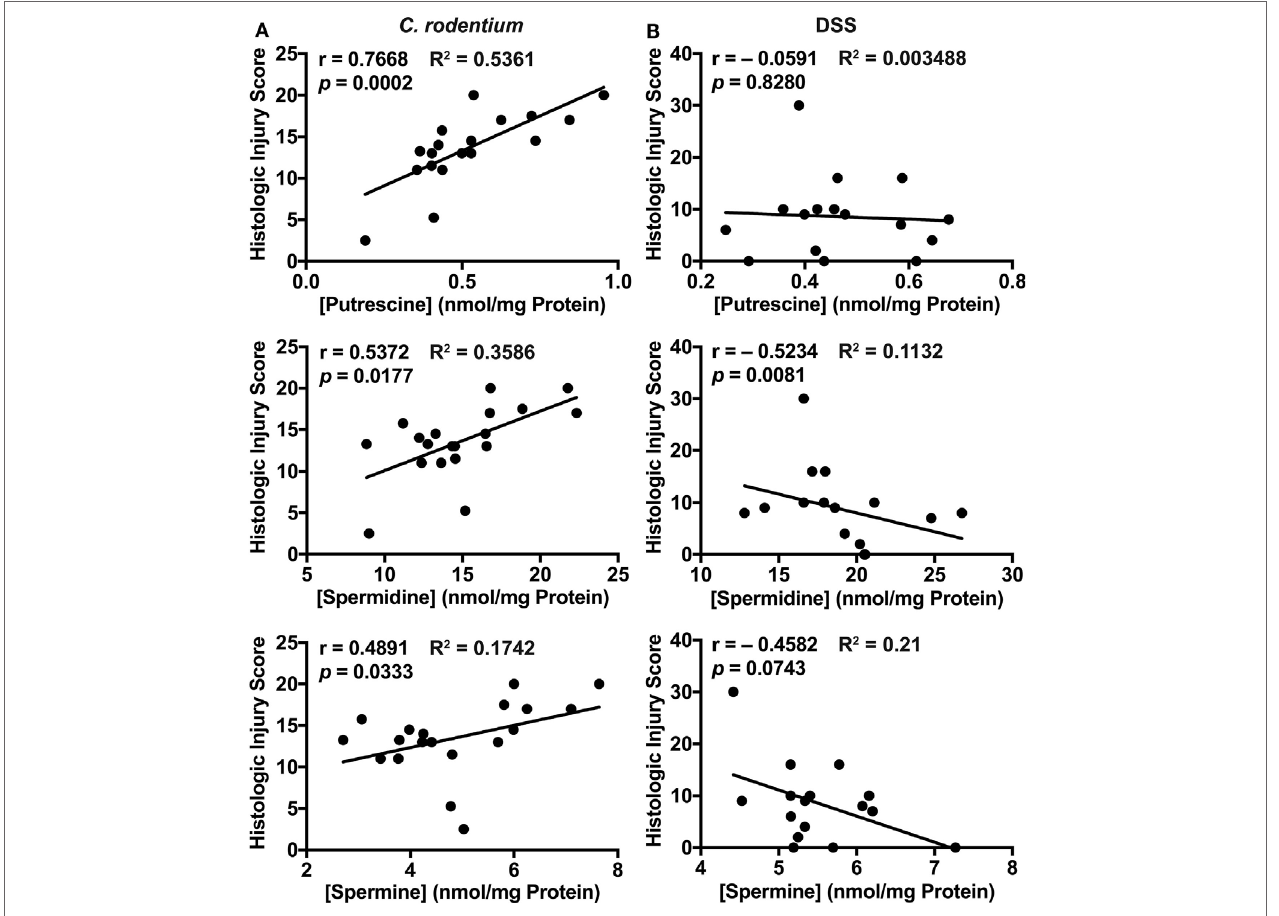
FigUre 5 | Correlation plots comparing histologic injury scores of wild­type mice (from Figures 1D and 2e ) and polyamine concentrations (from Figure 4 ) during Citrobacter rodentium (a) or dextran sulfate sodium (B) colitis. Statistical analysis was performed using the Pearson correlation